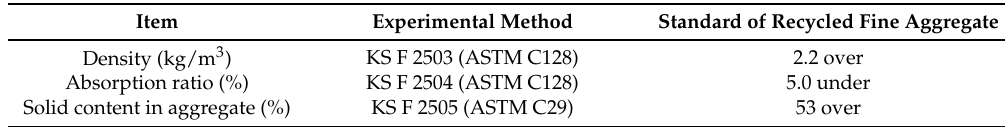
Table 4. Testing items and their measurement methods.